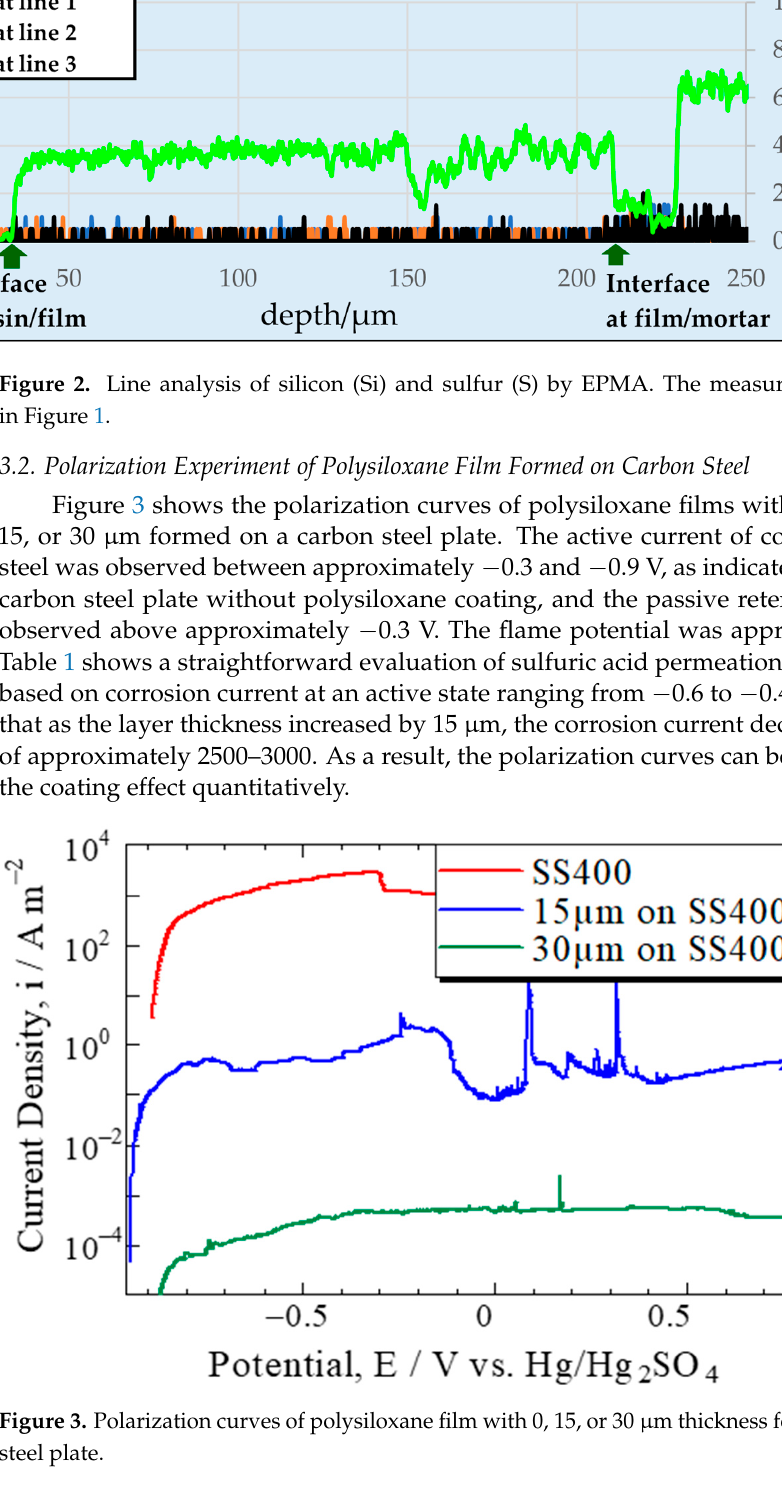
Figure 1. Microscopic image of the sample with three lines describing where EPMA line analysis was performed.